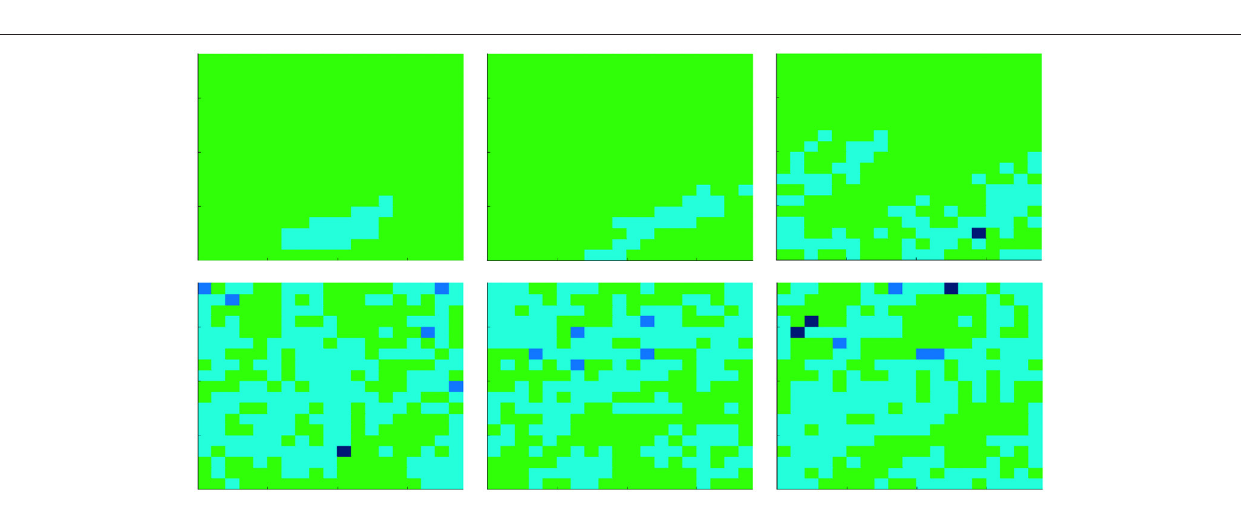
FIGURE 3 | Evolution of the agent population, composed of N = 400 cells, with a constant temperature T = 36. At the beginning, the amount of parasites corresponds to the 5 % of cells. Colors represent the state of cells: those green are healthy (i.e., not infected by bacteria), while those cyan, blue, and black are infected. The darkness of infected cells indicates the parasites’ payoff, i.e., the darkest the richest (i.e., the strongest vs. cell attacks). Each subplot refers to a different time step, starting from t = 0 (i.e., the first one) up to t = 200,000 (from left to right, and from the upper part to the lower part). All plots refer to a single realization of a